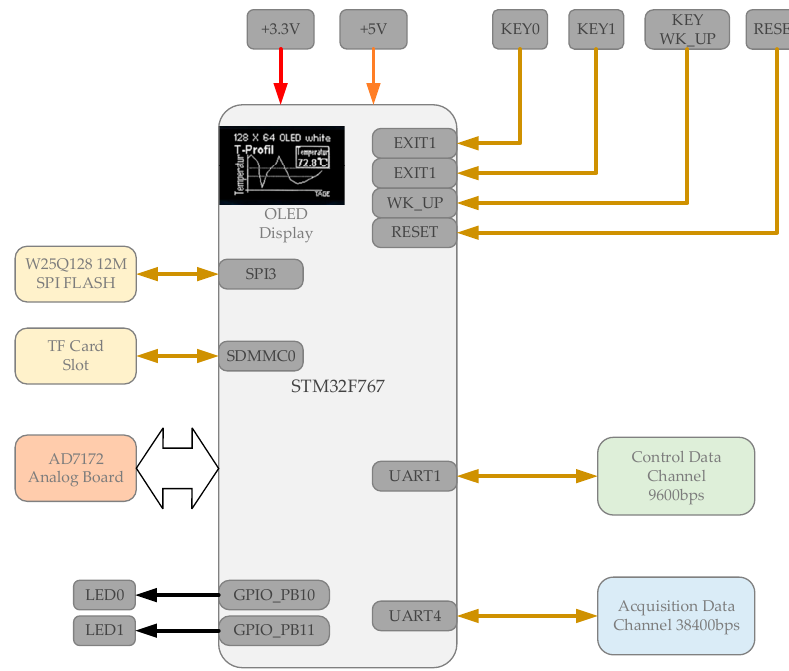
Figure 5. The functional block diagram of the main control board. The main control board was responsible for saving data to the flash memory or MicroSD card on the board. It could also transmit data to the ground station synchronously via Bluetooth and display the real-time waveform on the computer.